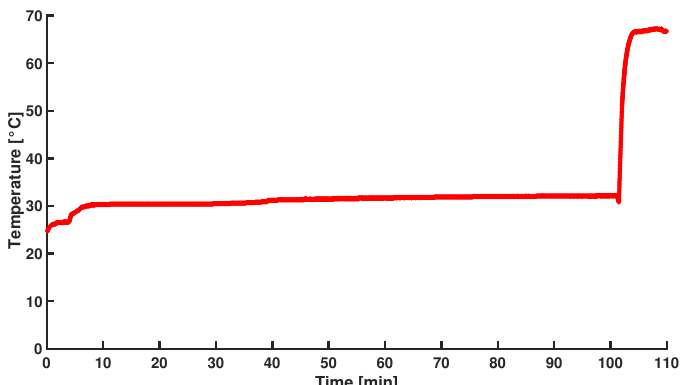
Figure 14. Temperature profile recorded with the thermocouple inside the water-filled temperature control chamber during the on-chip MDA